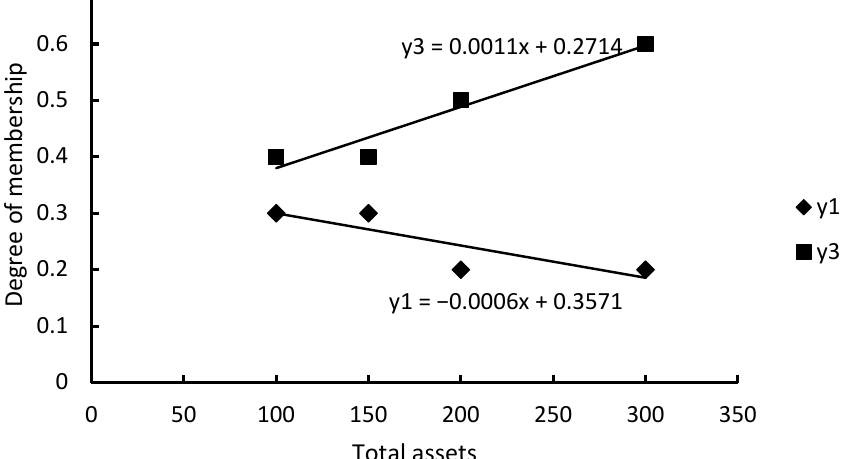
Figure A7. Single factor evaluation for the index of total assets (more than 100 ten thousand yuan).